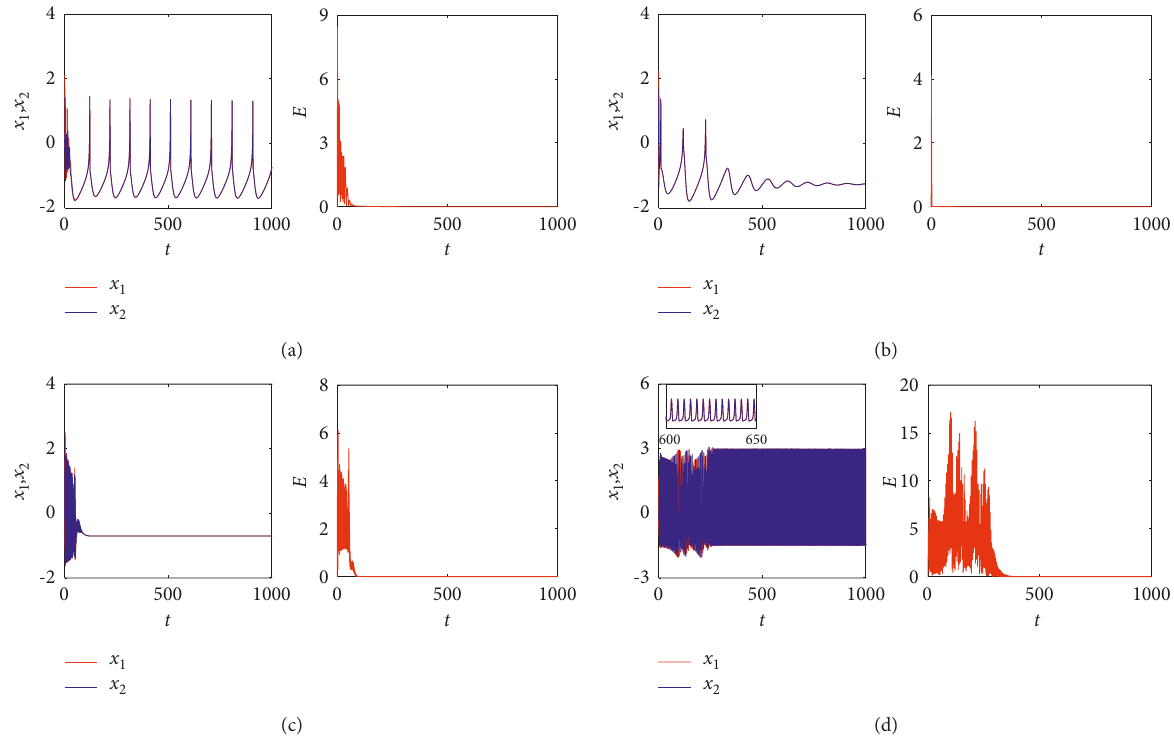
Figure 10: The time series of membrane potentials x (red line) and x (blue line), and error functions of the coupled model at case 2 1 2 (bursting and quiescent neurons). For (a) spiking firing synchronization with τ � 0 . 01 and D � 1; (b) quiescent state synchronization with τ � 0 . 01 and D � 15; (c) quiescent state synchronization with τ � 0 . 5 and D � 5; and (d) periodical firing synchronization with τ � 3 and D � 5. The initial values are selected with (0.1, 0.01, 1.05, 0.1, 0.01, 1.05).